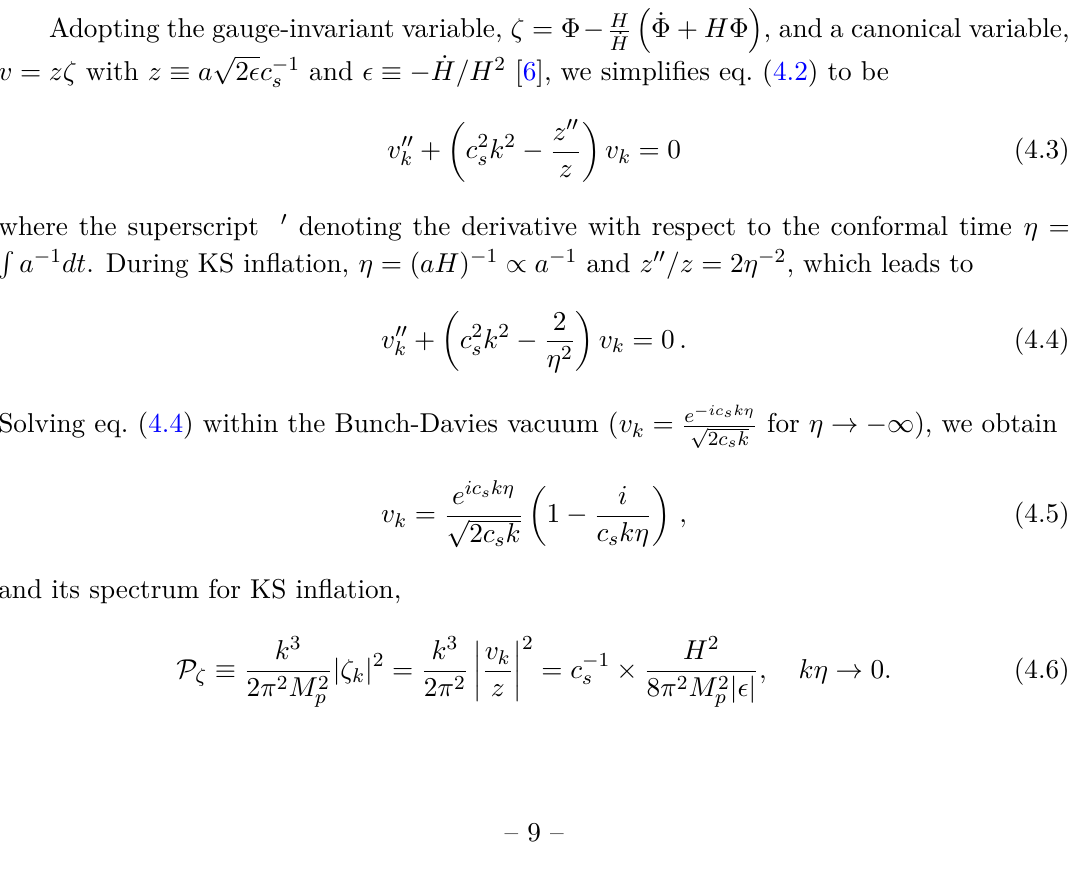
Figure 4 . The contour plot of N e in ( m s , λ ) -plane for N e ≥ 62 in the KS inflation, using eq.